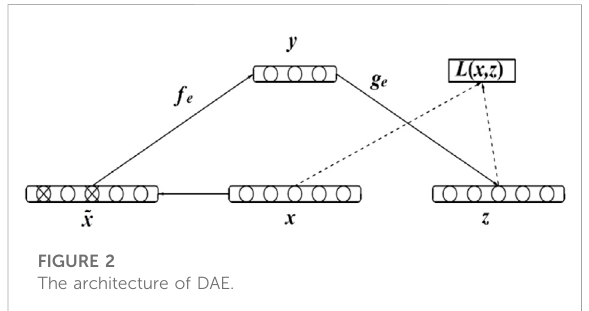
FIGURE 2 The architecture of DAE.